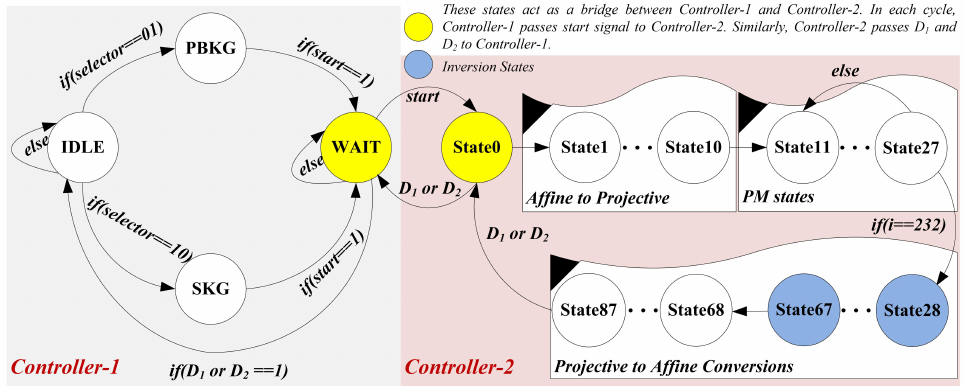
Figure 4. FSM controller of our proposed ECDH accelerator